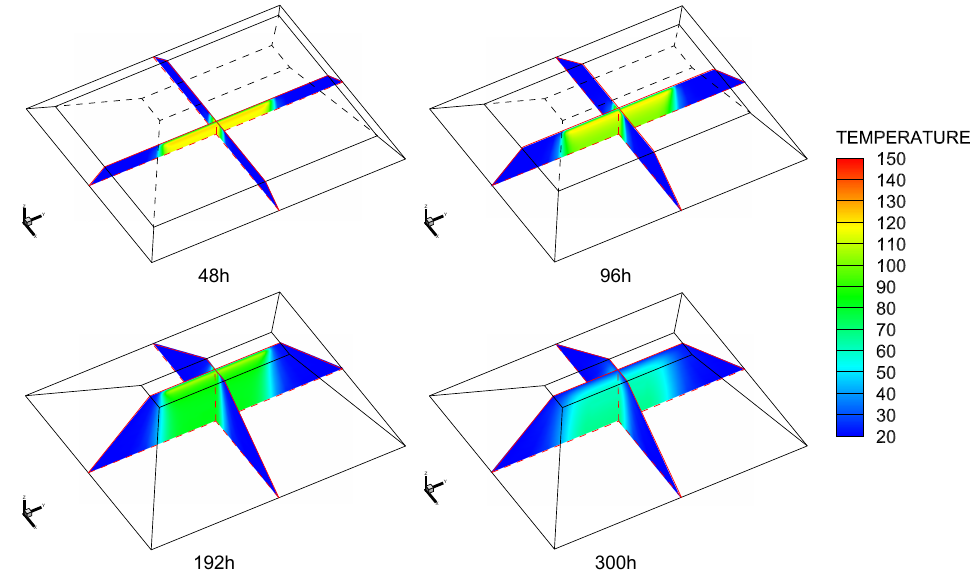
Figure 13. The temperature contour in vertical and cross sections of Example 3.